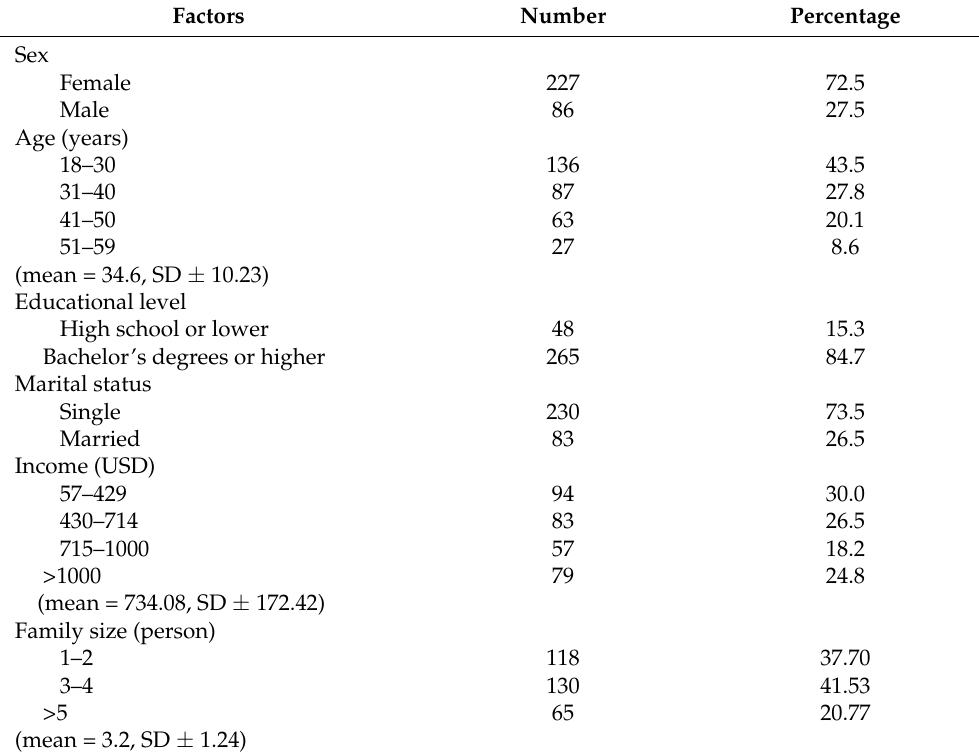
Table 1. Participants’ demographic